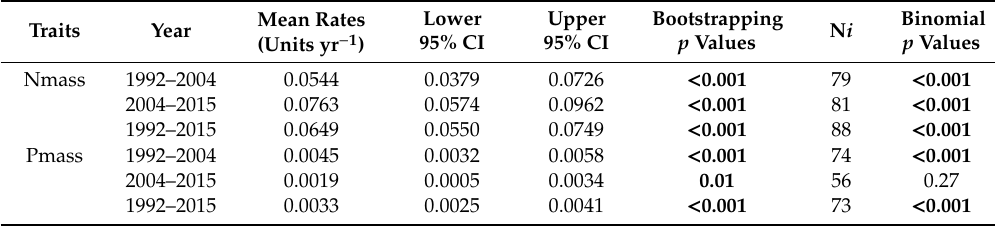
Figure A1. Temporal trends of quadrats’ functional traits (based on abundance) in the monsoon evergreen broad-leaved forest. Table A1. Annual rates of change in quadrats’ trait values in periods of 1992–2004, 2004–2015, and